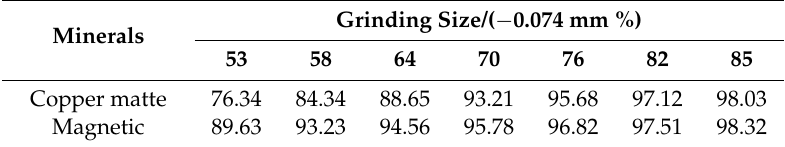
Table 8. Liberation degree of metal minerals under different grinding sizes for modified slag/%. Minerals